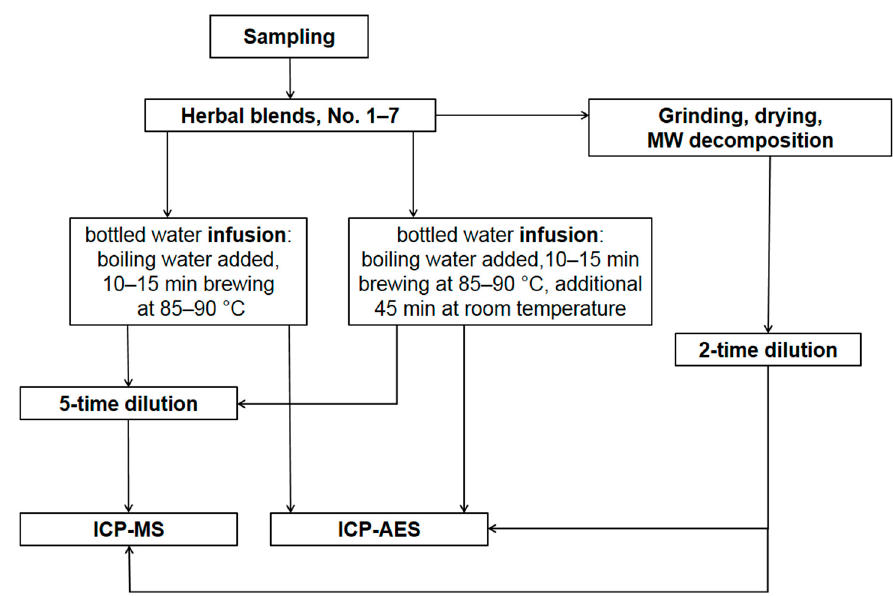
Figure 1. Flowchart illustrating sample preparation and analysis.